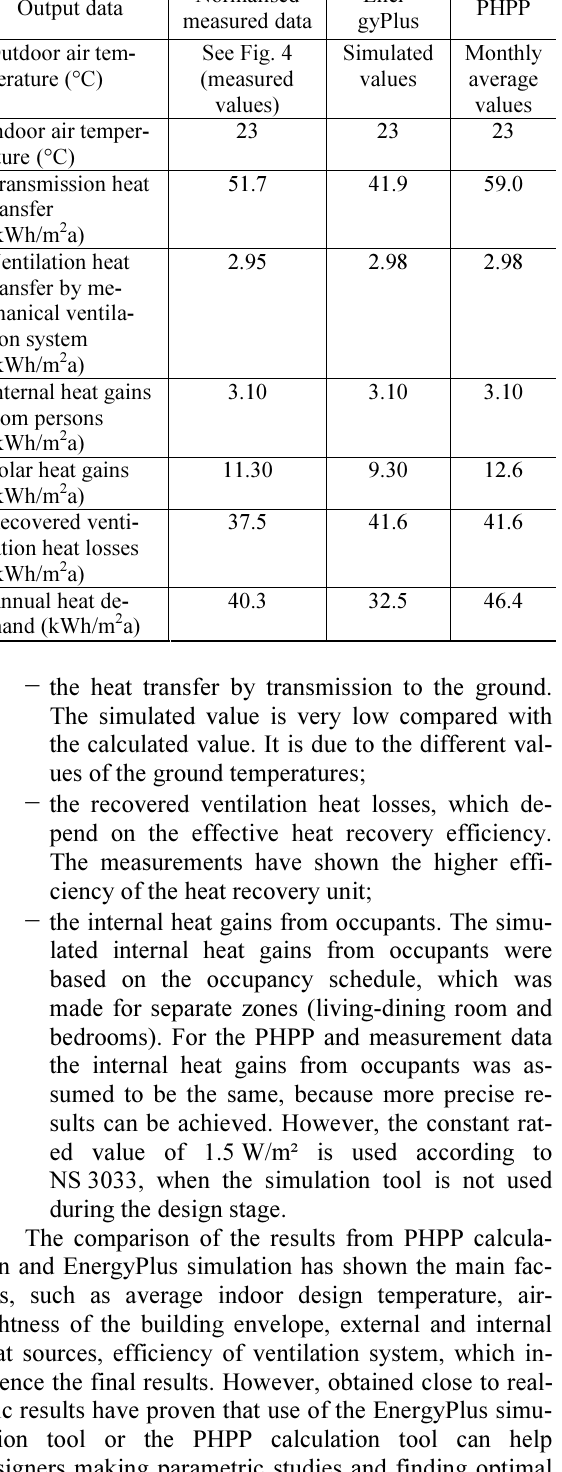
Table 4. The output data of simulation and calculations Output